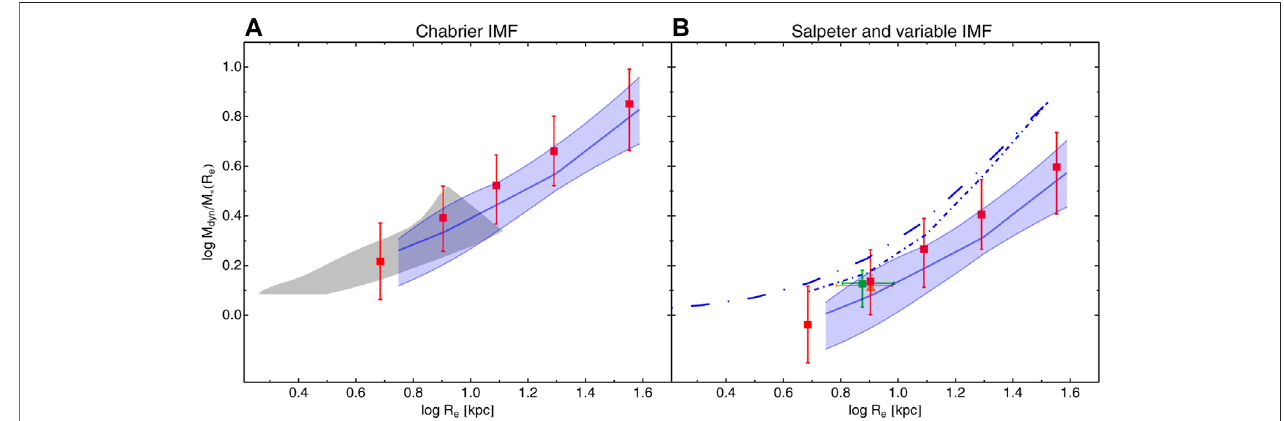
FIGURE2| Thetotal-to-stellarmassratio M dyn / M p withinrest-frameeffectiveradius, R e ,asafunctionofrest-frameeffectiveradius R e ,assumingaChabrierIMF (A) and Salpeter and variable IMF (B) . Red and blue symbols are for KiDS and SPIDER, respectively. Following Figure 1 , red squares with errors bars and solid lines with shaded regions adopt a fi xed IMF (Chabrier and Salpeter in the two panels). Short-dashed-dotted is for IMF variable from Tortora et al. (2013) and Tortora et al. (2014a) with log M p / M ⊙ > 11.2, while long-dashed-dotted with log M p / M ⊙ > 10.5. The gray region is from IllustrisTNG (Wang et al., 2020), extracted from Figure 15 in Shajib et al. (2020); note that in that fi gure they only show results for R e ≲ 10 kpc. Orange triangle is from the lensing analysis in Shajib et al. (2020), in a good agreement with Auger et al. ’ s (2010a) results, plotted in